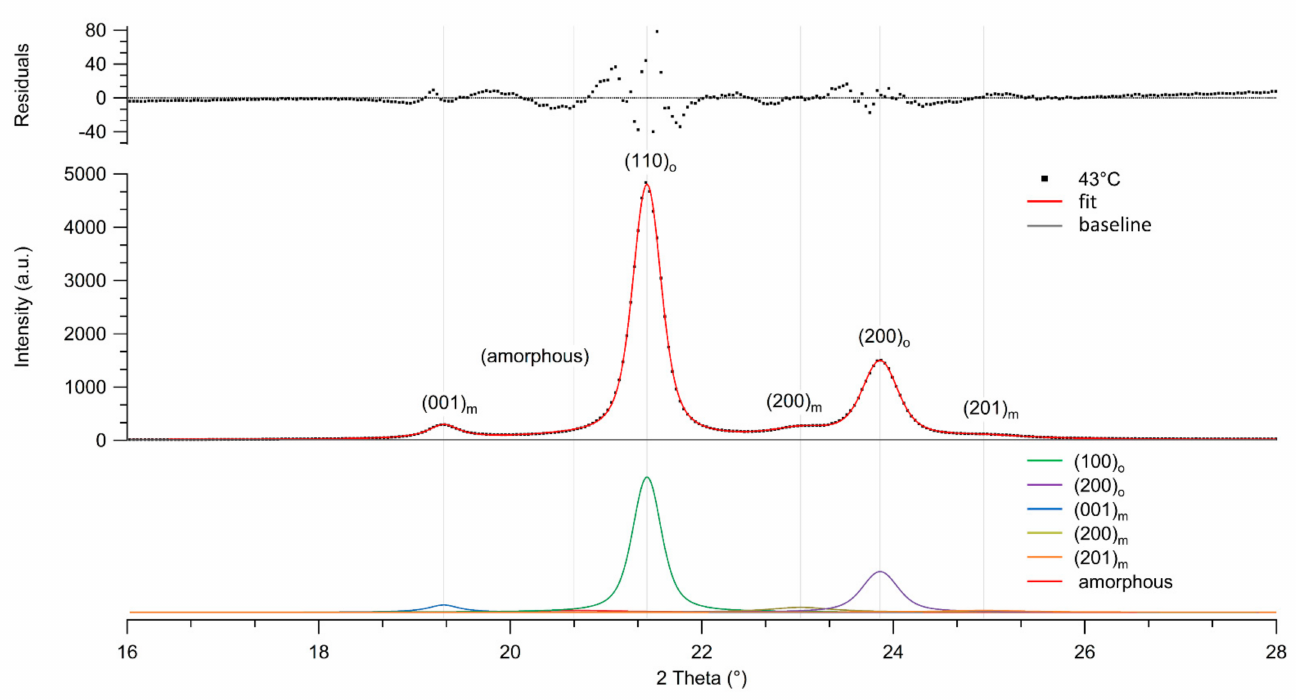
Figure 2. WAXS diffractogram of thermally aged UHMMPE fibers stored at nominally 43 ◦ C for about 81 weeks. The resolved peaks for the orthorhombic and monoclinic crystals, as well as the amorphous halo are shown; the fit and residuals are also presented, and the chi squared value is χ 2 =